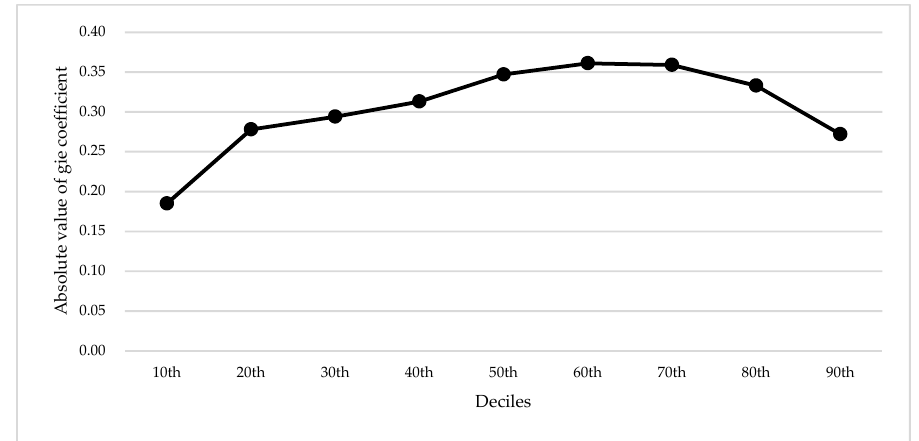
Figure 5. The coefficients of gie in quantile regression.